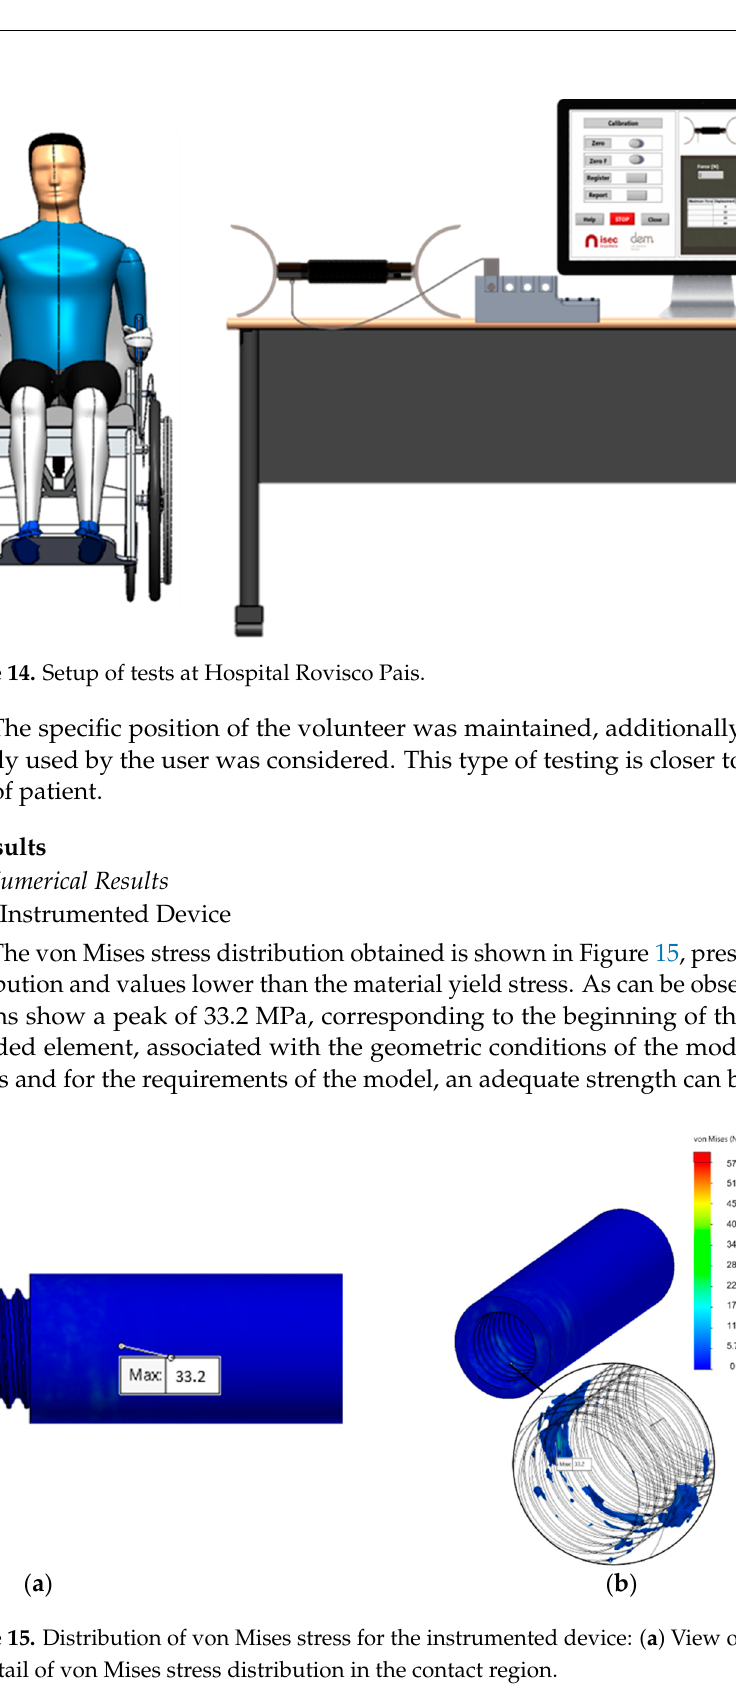
Table 2. Maximum values of von Mises stress on the components.